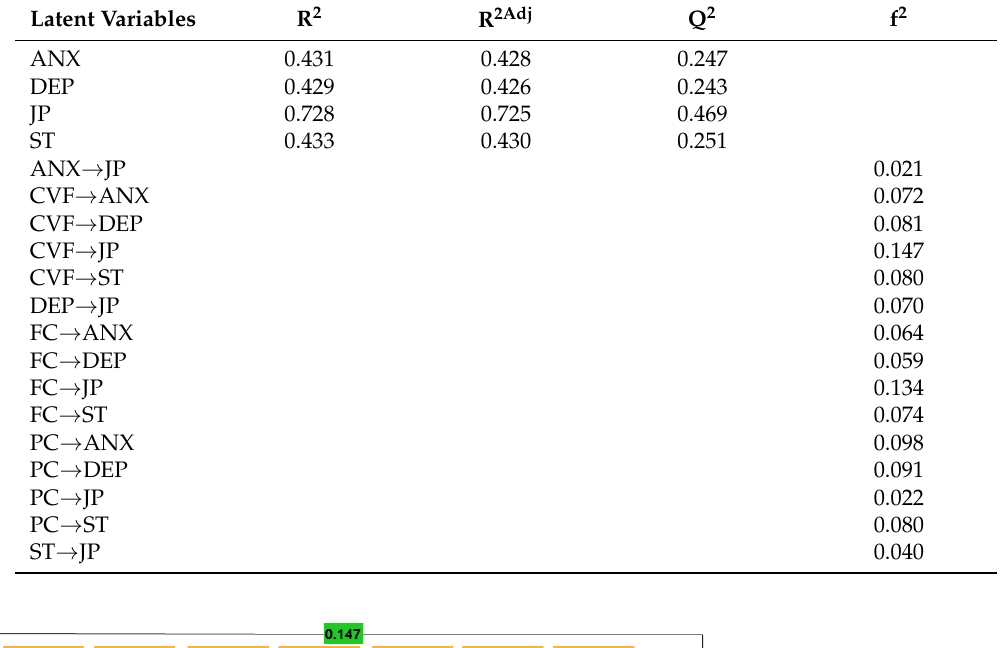
Table 11. Quality Criteria (R 2 , f 2 , and Q 2 ).